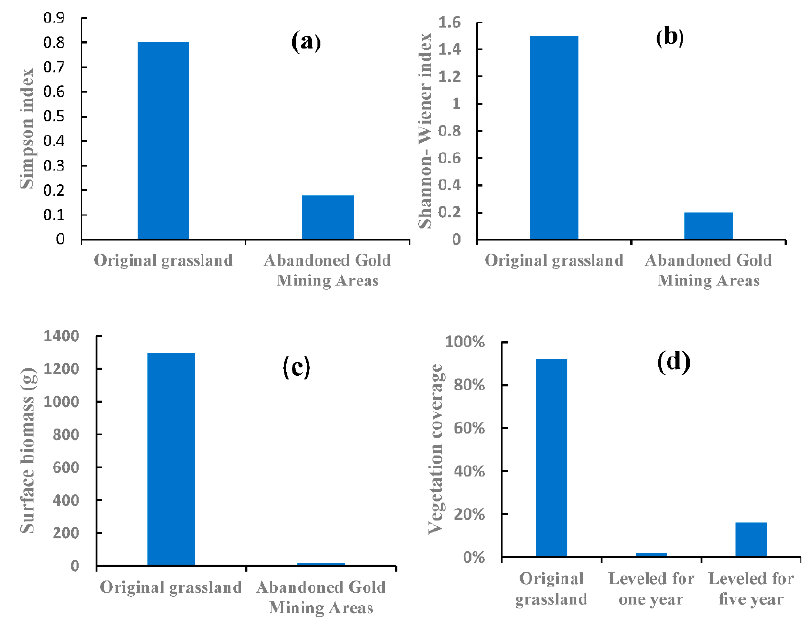
Figure 4. Comparison of diversity index, surface biomass and vegetation coverage between original grassland and abandoned mining area. Note: ( a – d ) are subtitle of Figure. ( a ) is Simpson index, ( b ) is Shannon-wiener index, ( c ) is surface biomass, and ( d ) is vegetation coverage.